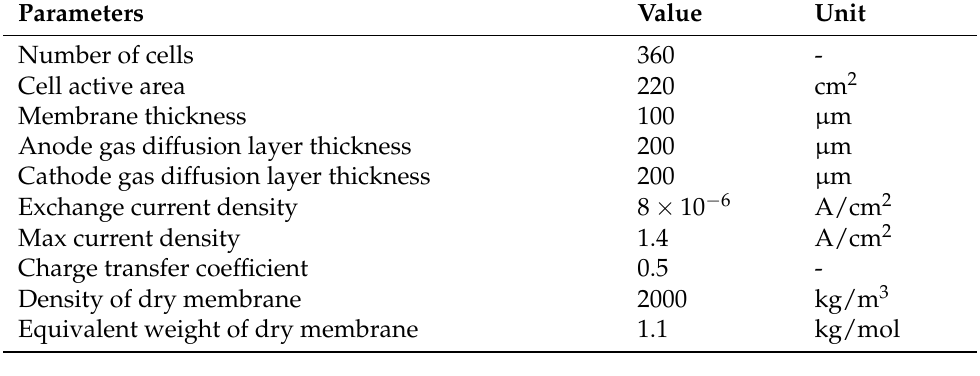
Table 3. Main characteristics of the fuel-cell stack.